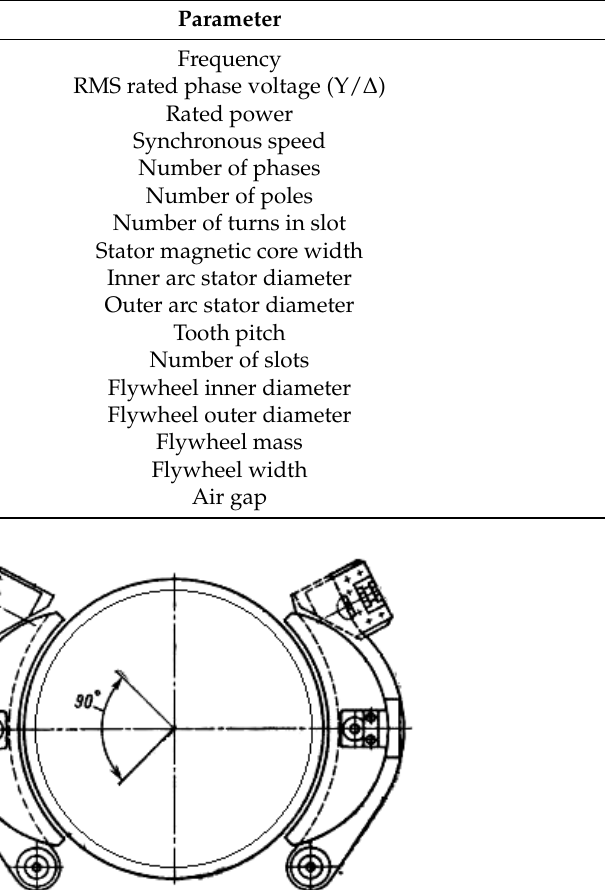
Figure 14. Position of the arc stators relative to the secondary flywheel. Table 8. Parameters of the screw press arc IM.